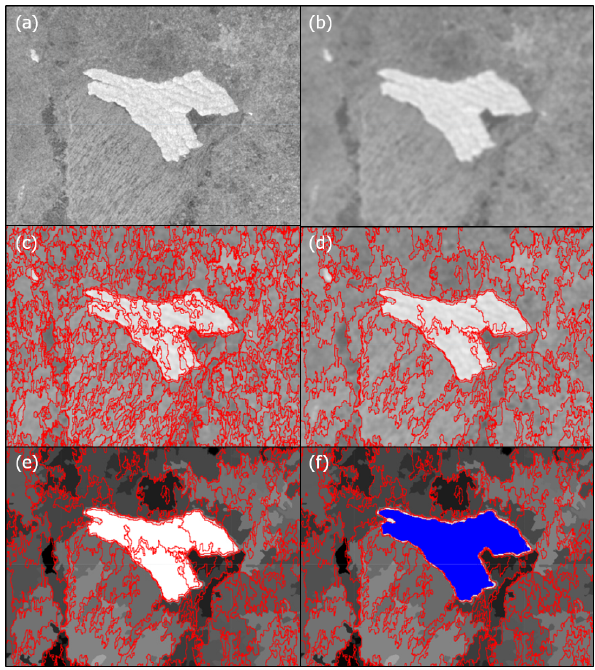
Figure 2. An example of the segmentation result for different levels: (a) original image (22 May 2019), (b) smoothed image by Gaus- sian filter, (c) segmented image (seed = 40), (d) segmented image (seed = 80), (e) backscatter ratio ( = γ/α ) image with segmented result, and (f) segments identified as iceberg (blue polygon). Seg- mentation and other processing shown in panels (c) – (f) are based on the smoothed image in panel (b)